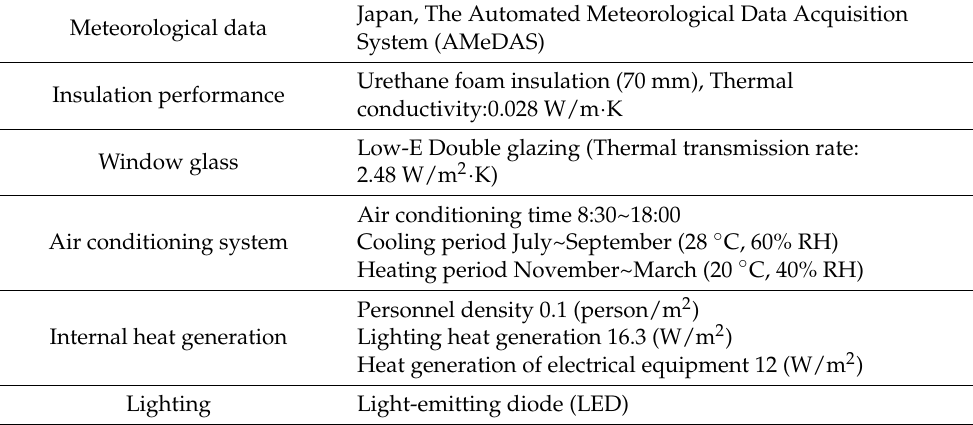
Table 4. Simulation